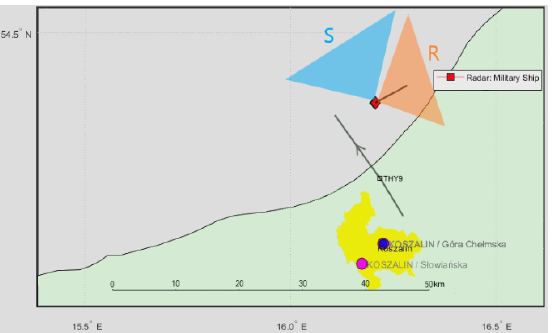
Figure 22. Situation map for the THY9 airplane (Boeing Dreamliner).